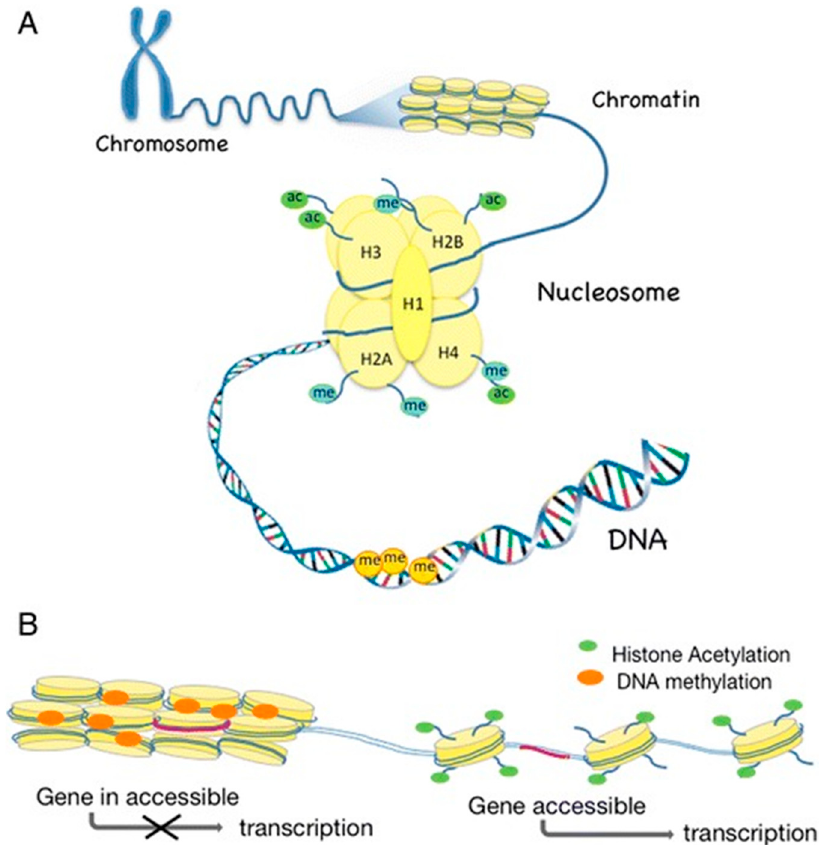
Figure 1. Major epigenetic mechanisms and their influence on gene transcription. ( A ) Chromatin structure (Ac: acetylation; Me: methylation). ( B ) Influence of DNA methylation and histone modifications on chromatin formation and gene expression. From Larsson, Curr Oral Health Rep, 2017. Reproduced under the terms of the Creative Commons Attribution 4.0 International License.